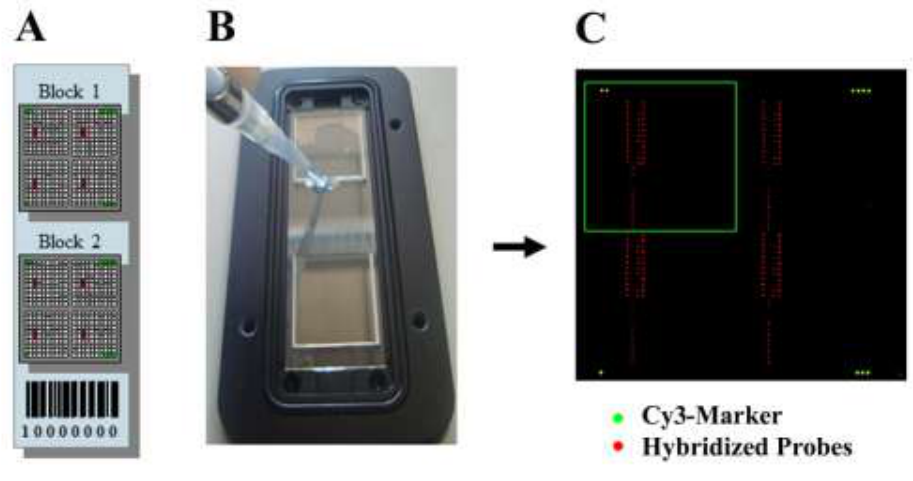
Figure 2. ( A ) Schematic overview of a microarray slide consisting of two blocks. Each block has four identical grids of probes; ( B ) Glass slide during loading procedure of a hybridization mixture; ( C ) Visualization of an hybridized slide after scanning: the green spots indicate the Cy3-Marker spotted at the four corners of the slide; the red spots indicate the positions where a fluorescent fragment of Amphora coffeaeformis SIT gene recognized the complementary oligonucleotide probes; the green square indicates one of the four sectors of one